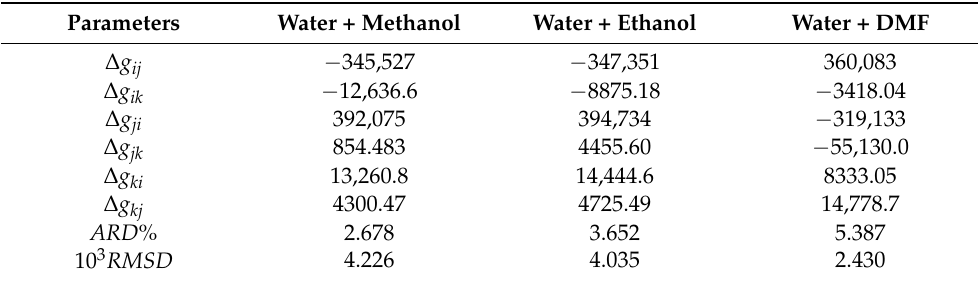
Table 7. Model parameters of NRTL model for 1,5-pentanediamine adipate dihydrate in the investi- gated binary solvent mixtures a,b,c .